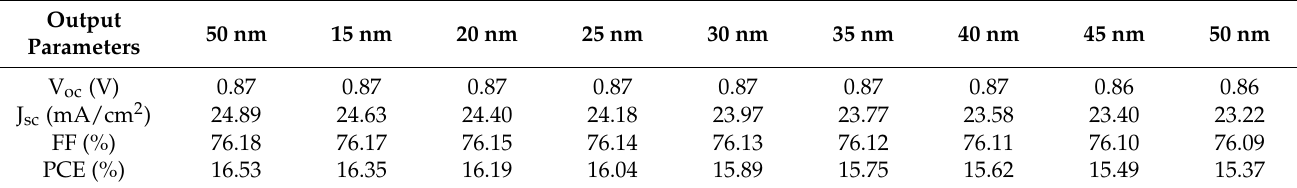
Table 4. Effect of the CdS thickness on the output